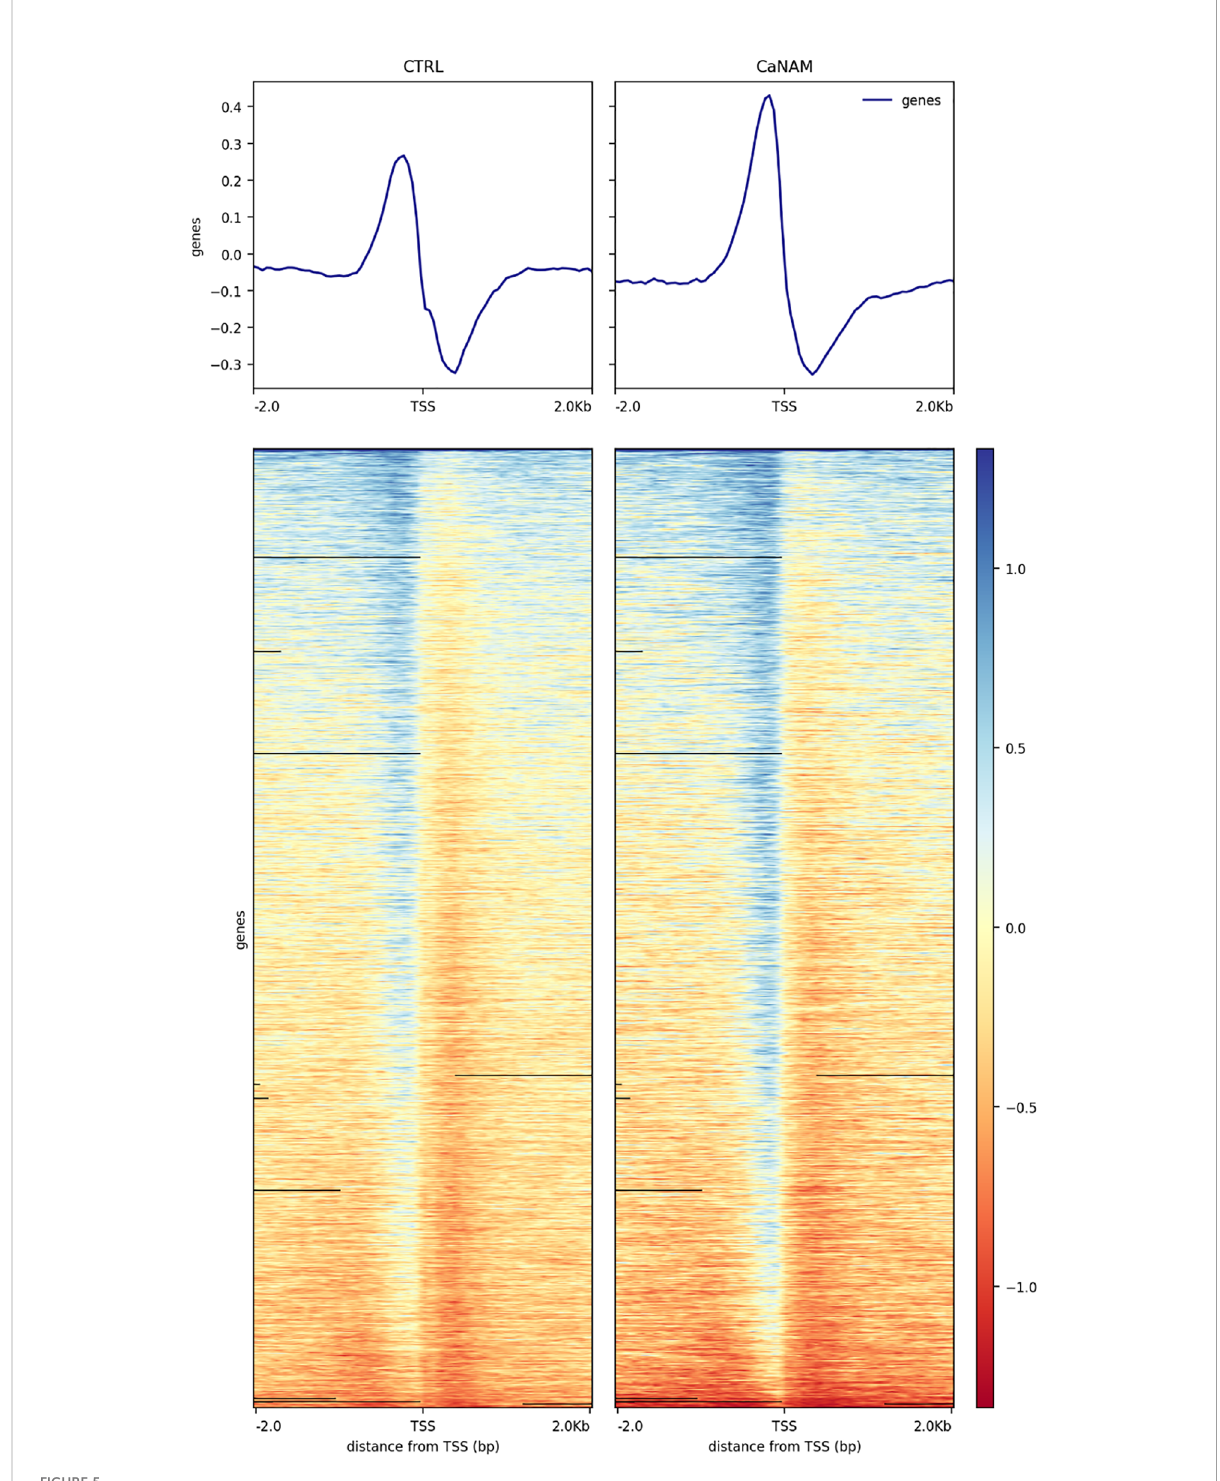
FIGURE 5 Pro fi le heatmap around TSS of RefSeq genes. Representative heatmaps showing the scores associated with genomic regions around the TSS of genes (± 2kb). The gradient blue-to-red color indicates a high-to-low log 2 ratio of the number of reads between the IP and the respective Input in the corresponding